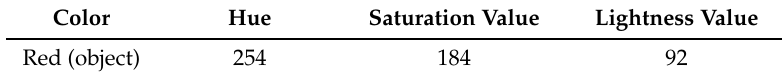
Table 2. Object HSL color values.